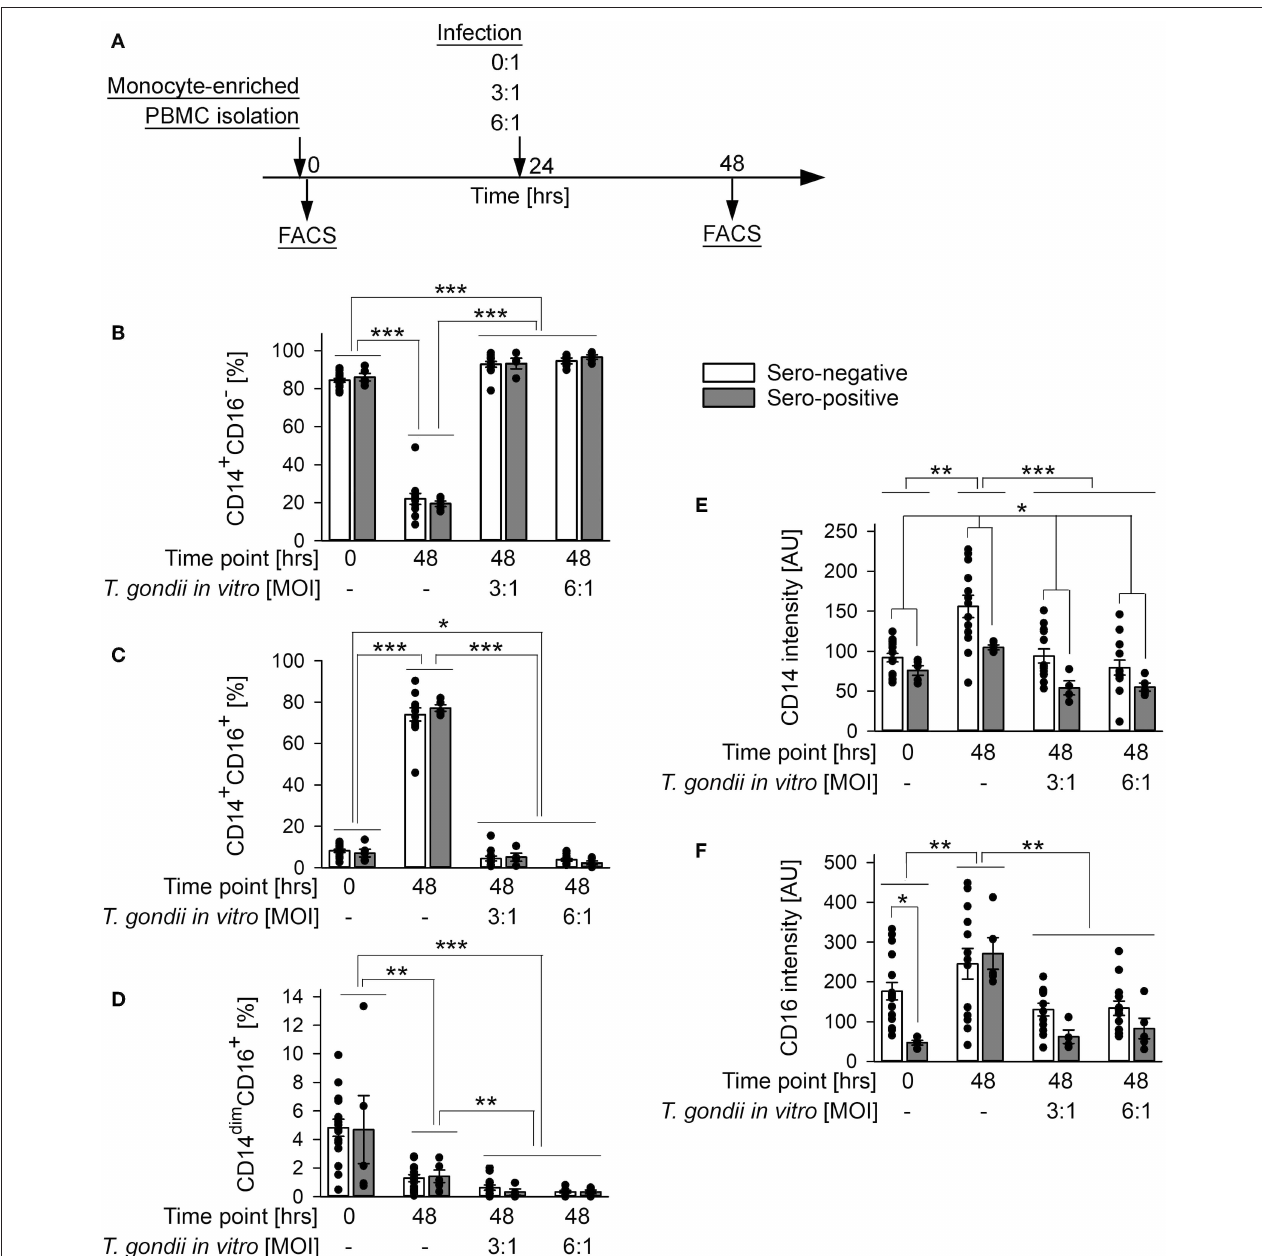
FIGURE 3 | Impact of in vitro infection of monocyte-enriched PBMCs with T. gondii on subset distribution and expression of CD14 and CD16 of monocytes from blood donors with or without chronic toxoplasmosis. (A) Monocyte-enriched PBMCs were isolated from blood samples and were either directly FACS-analyzed (0h) or cultivated in vitro for 48h and parasite-infected or not during the final 24h as indicated and then FACS-analyzed. (B–D) Percentages of CD14 + CD16 − (B) , CD14 + CD16 + (C) and CD14 dim CD16 + (D) subsets among monocytes from T. gondii seropositive (gray bars) or seronegative (open bars) individuals. (E,F) Expression levels of CD14 (E) and CD16 (F) on monocytes from T. gondii seropositive or seronegative blood donors. Data represent means ± S.E.M. from 5 T. gondii seropositive and from 13 out of 16 seronegative blood donors which had been randomly selected for in vitro infection assays; outlyers were excluded. Individual data points are also indicated. Significant differences between groups were identified by ANOVA (*** p < 0.001; ** p < 0.01; * p < 0.05).